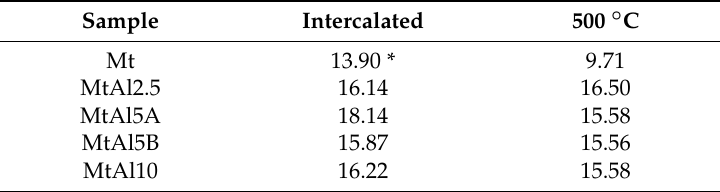
Figure 1. Powder X-ray diffractograms of the pillared solids calcined at 500 °C. For comparison, the diffractograms of the raw montmorillonite (RMt) and of this sample calcined at 500 °C (Mt) are also given. Table 4. Basal spacing (Å) for intercalated and calcined samples.